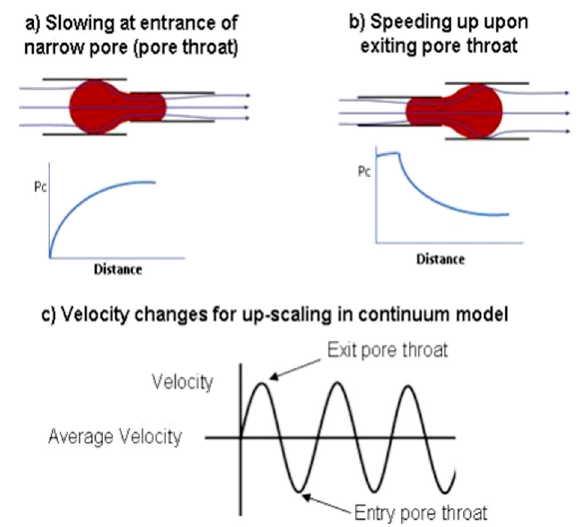
Figure 21. Conceptual model of active ganglion motion ( a ) slowing down when reaching the pore throat entrance and ( b ) speeding up when exiting pore throat. ( c ) Oscillation function capturing flow variability for specific domain in flow space.